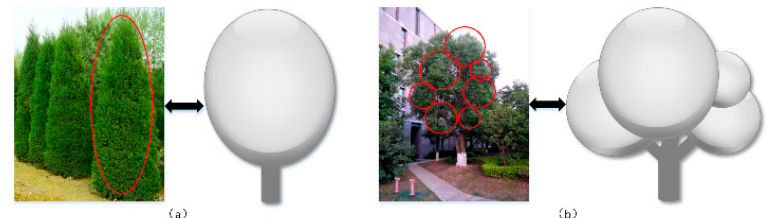
Figure 4. Two different tree styles and the corresponding conceptual models based on the sphere-board approach: ( a ) the crown is a single cluster of foliage and twigs (CFT) and can be represented by one sphere-like surface; ( b ) the crown is composed of multiple CFTs and can be represented by multiple sphere-like surfaces.